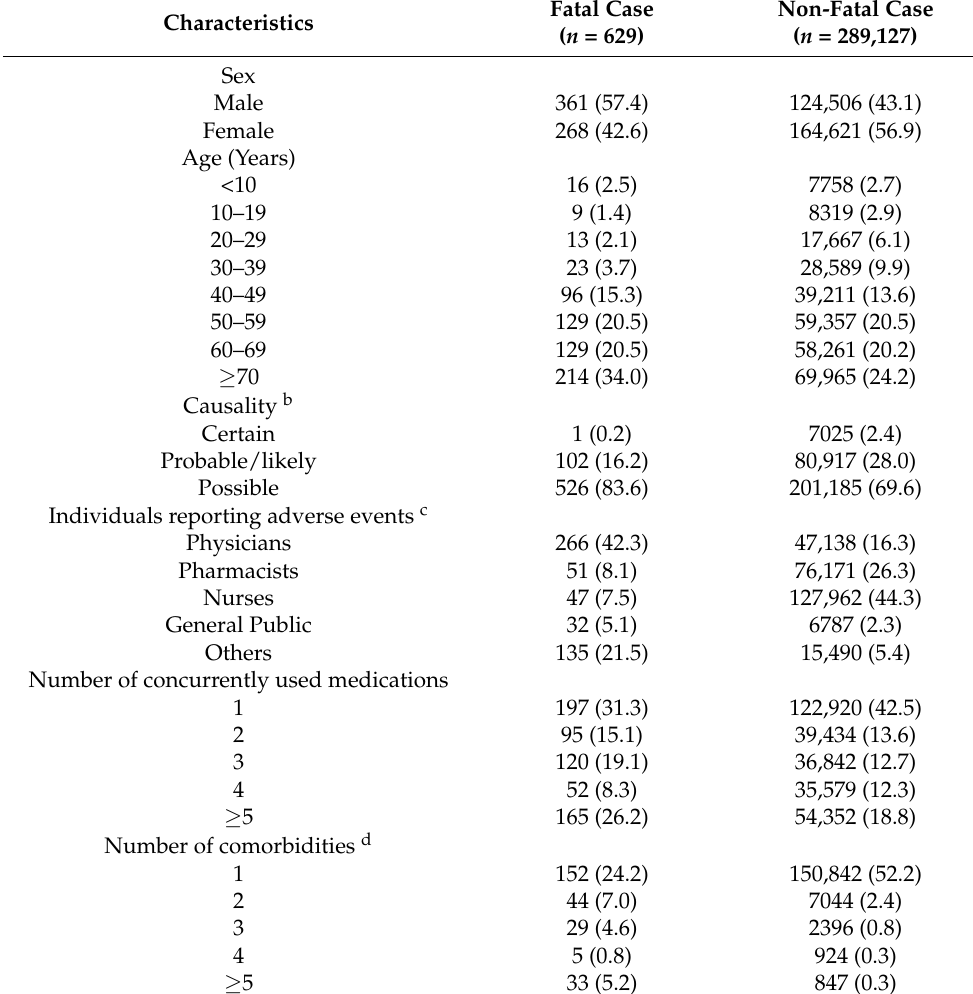
Table 1. Baseline demographic characteristics of patients included in this study ( n = 289,756) a